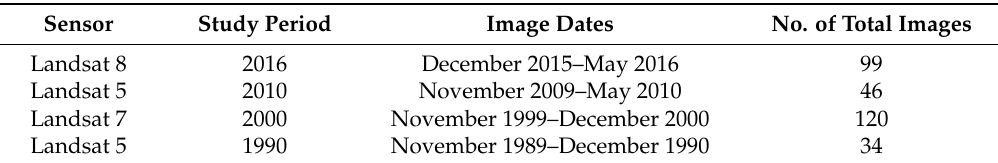
Table 2. Details of the satellite images used in the study.